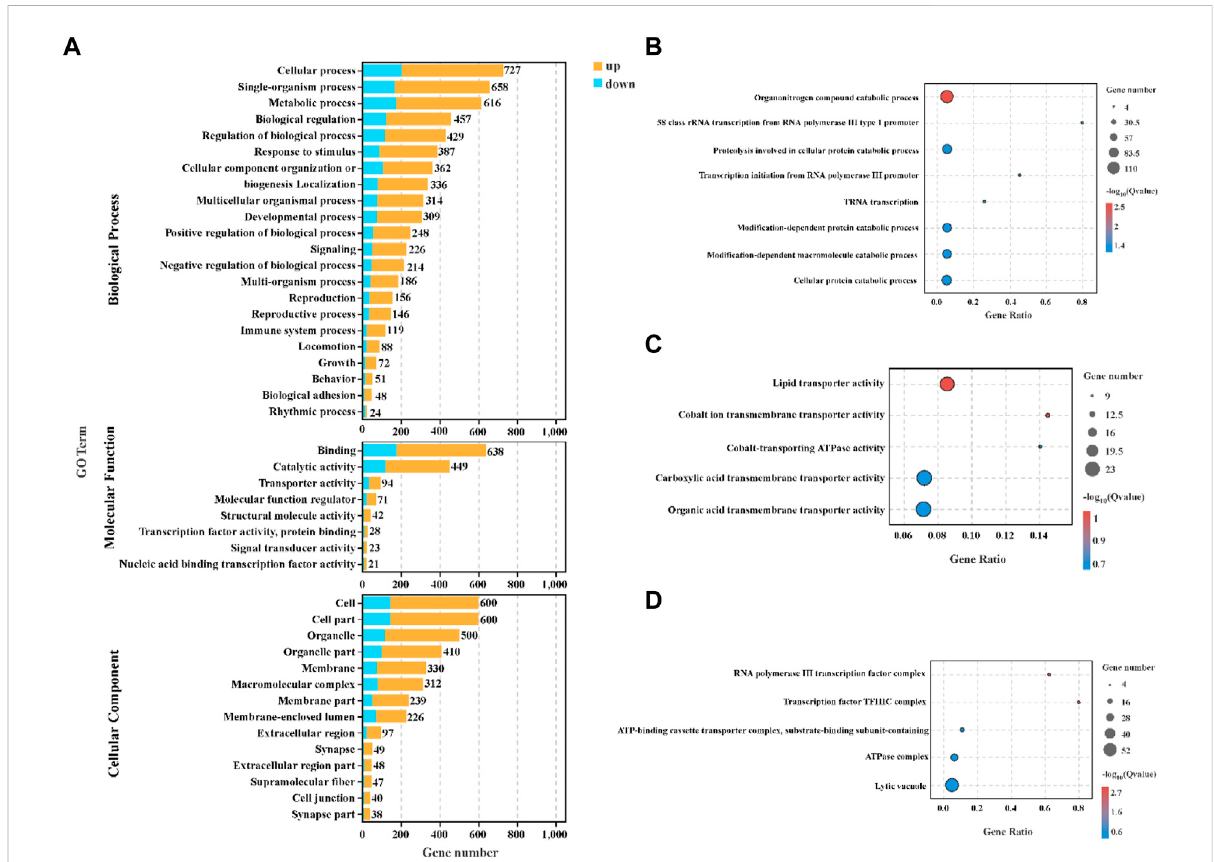
FIGURE 4 GO enrichment analysis in the hepatopancreas of C. quadricarinatus under two stocking densities (LD-vs-HD). (A) GO enrichment terms of DEGsinthreeontologies. (B) Thetop8GOtermsinthebiologicalprocess. (C) Top5GOtermsinthemolecularfunction. (D) Thetop fi veGOtermsin the cellular